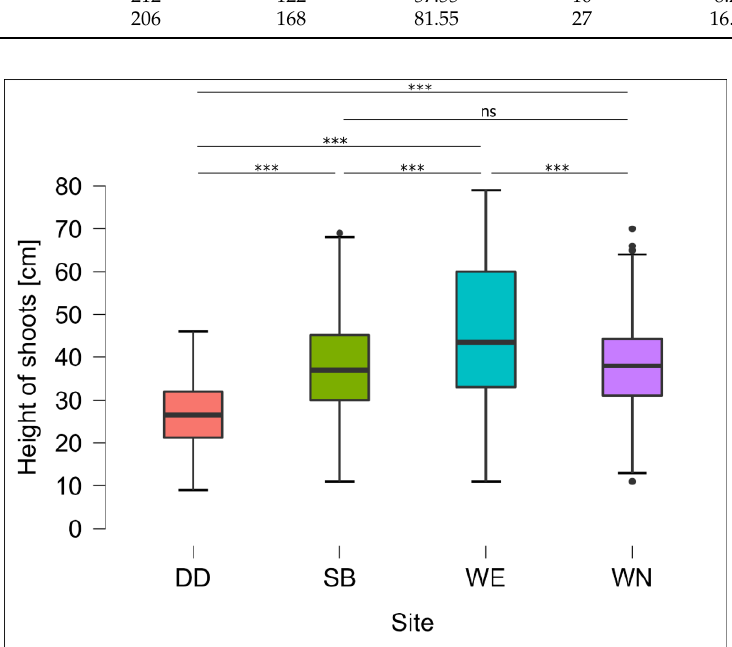
Figure 2. Variation in the height of Salix lapponum individuals two/three years after the completion of seedling planting on different types of habitats. SB — Stare Biele nature reserve, sedge-moss mire; of seedling planting on different types of habitats. SB—Stare Biele nature reserve, sedge-moss mire; DD — Derazina valley, sedge-moos percolation mire; WN — Wiejki Lake nature reserve north, active DD—Derazina valley, sedge-moos percolation mire; WN—Wiejki Lake nature reserve north, active quaking bog; WE — Wiejki Lake nature reserve east, inactive quaking bog; *** — very significant ( p < quaking bog; WE—Wiejki Lake nature reserve east, inactive quaking bog; ***—very significant 0.001); ns — not significant ( p ≥ 0.05 ). ( p < 0.001); ns—not significant ( p ≥